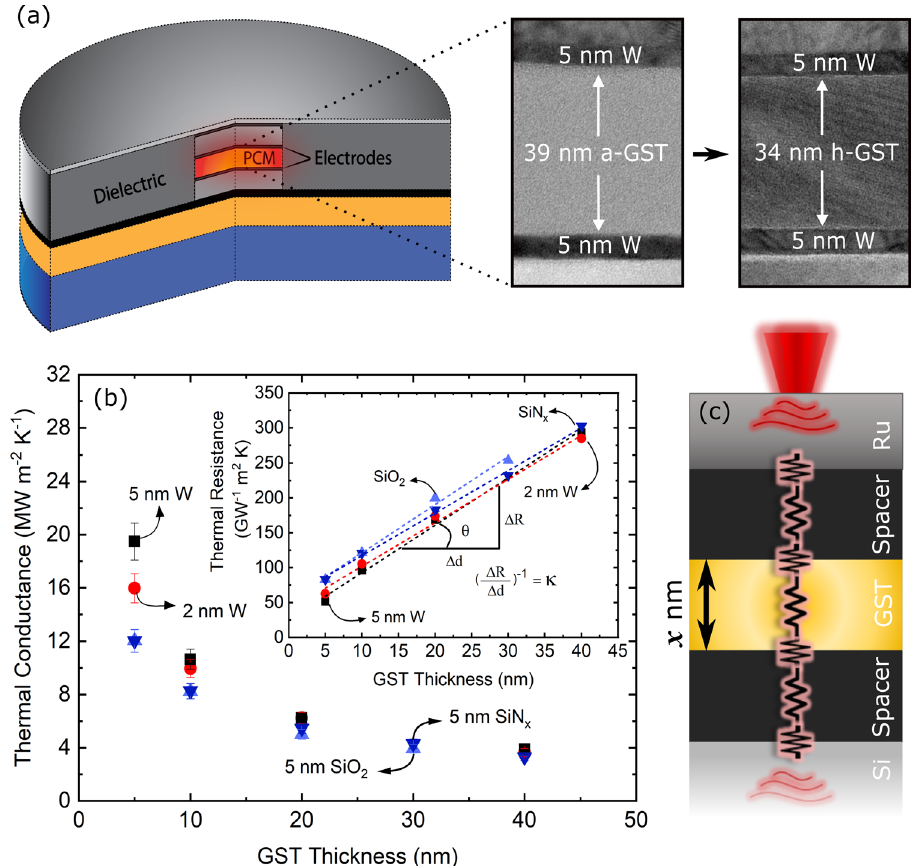
Fig. 1 Thin GST fi lms and contacts. a Schematic of a con fi ned phase change memory cell along with corresponding TEMs for a 40-nm a-GST and h-GST fi lm sandwiched between 5 nm tungsten spacers, b thermal conductance across Ru/spacer/GST/spacer/Si for different spacer compositions as a function of GST thickness. The inset shows thermal resistance as a function of thickness where the inverse of the slope for the fi tted line corresponds to the a-GST thermal conductivity. The average thermal conductivity estimated for a-GST is 0.15 ± 0.02 W m − 1 K − 1 . The error bars are calculated based on 7% uncertainty in the Ru transducer thickness, and c a schematic of the thermal resistances in series for the multilayer con fi gurations studied